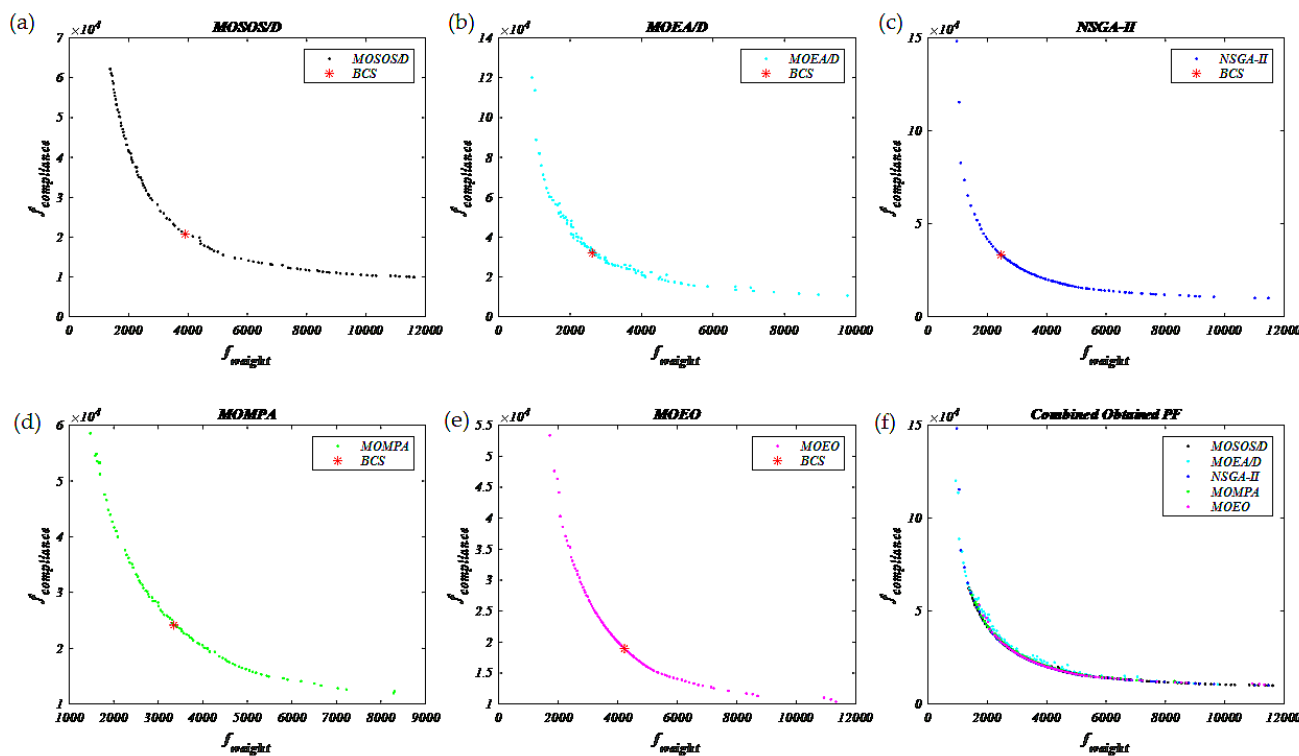
Figure 20. The best Pareto fronts for the 25-bar truss of the considered algorithms namely ( a ) MO-